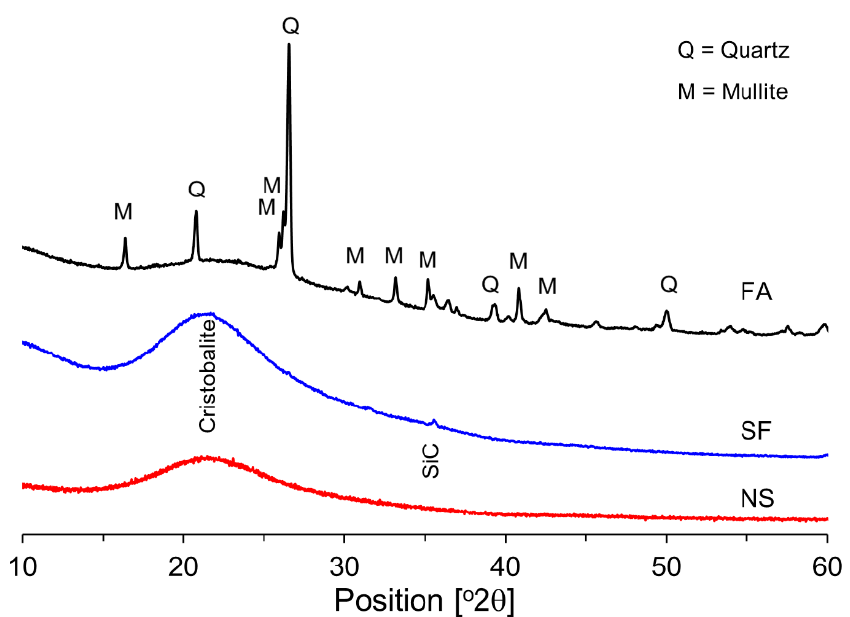
Figure 1. XRD patterns of FA, SF, and NS.